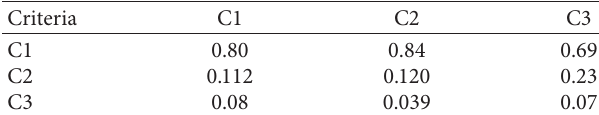
Table 4: Normlized matrix.